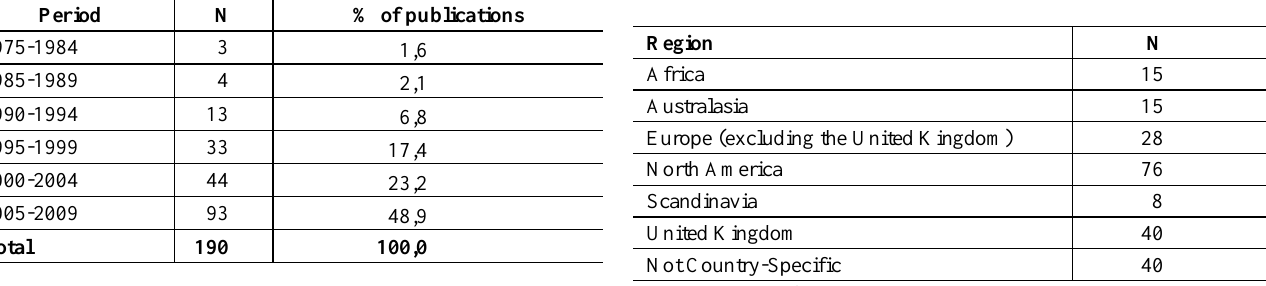
Table 2: Number of SRI articles published over time Table 3: Regions covered in the sample of academic literature considered